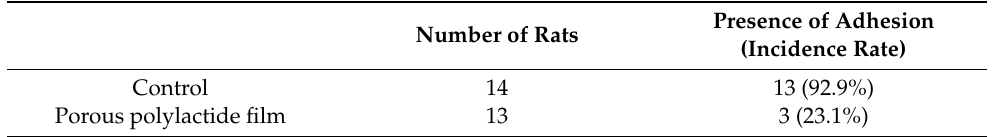
(chi-squared test, p < 0.001).